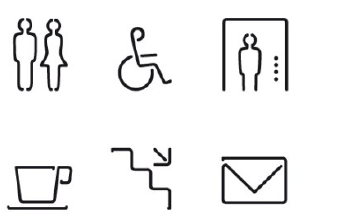
Figure 2. Symbolic expression with pictogram (URL-1, 2017).